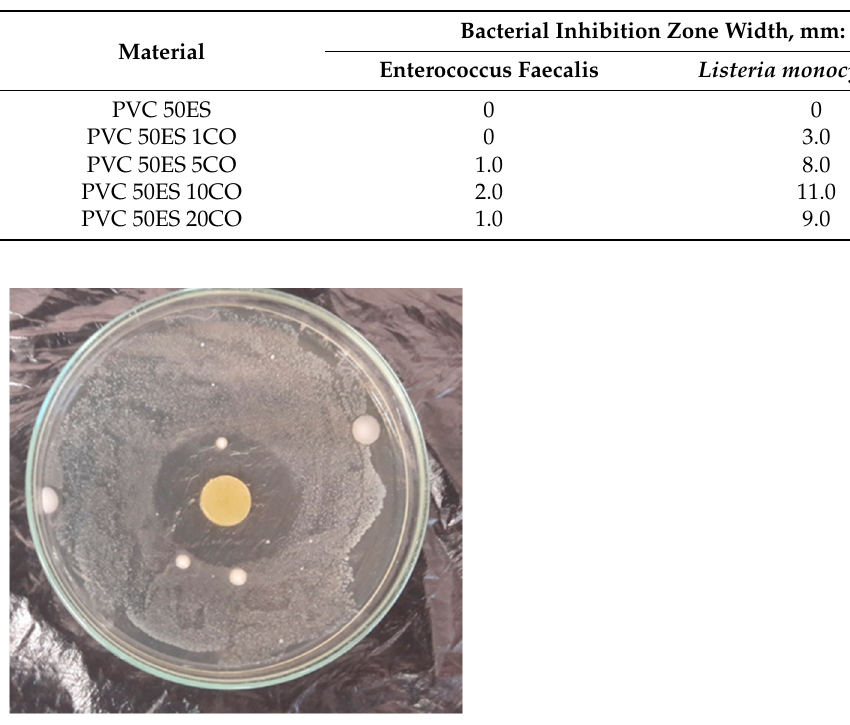
Table 6. Influence of different CO concentrations in PVC material on the bacterial inhibition zone. Table 6. In fl uence of di ff erent CO concentrations in PVC material on the bacterial inhibition zone.